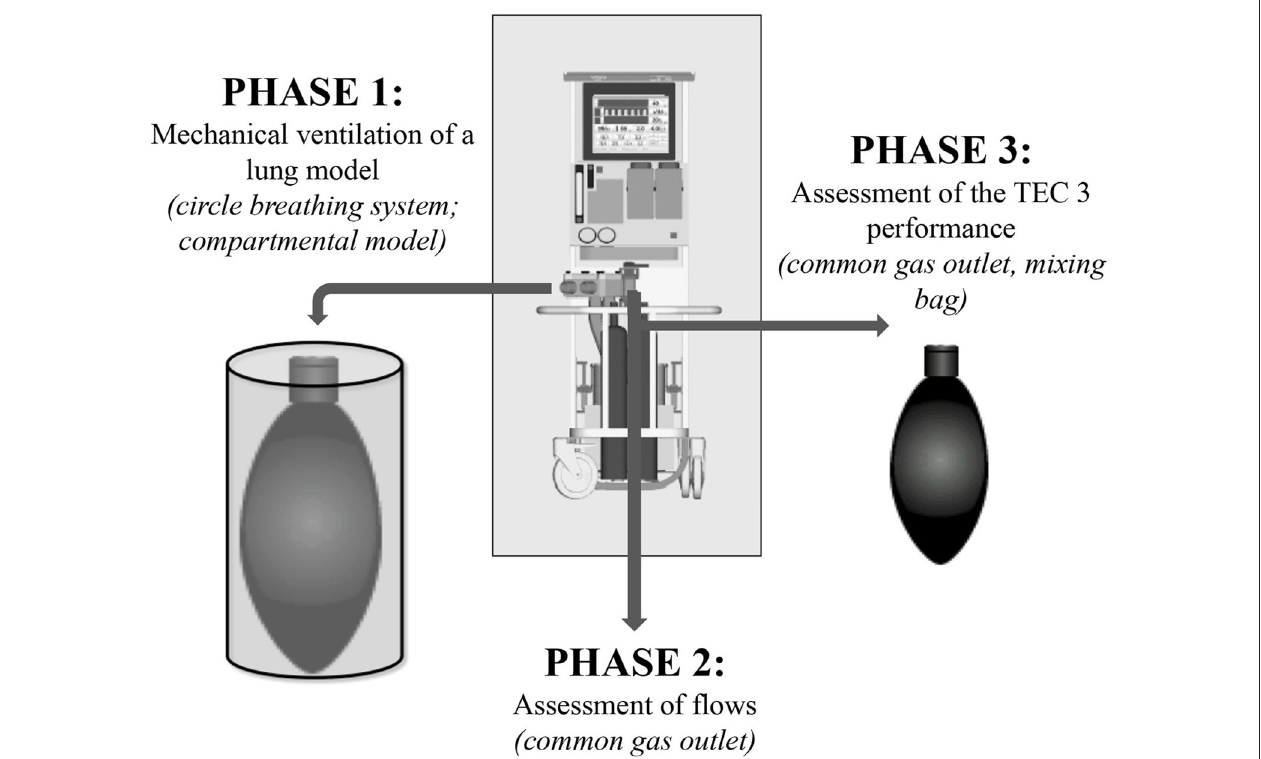
FIGURE 1 | Steps of investigation of the manual or computer-driven flowmeters’ different performance on isoflurane changes in Tafonius.